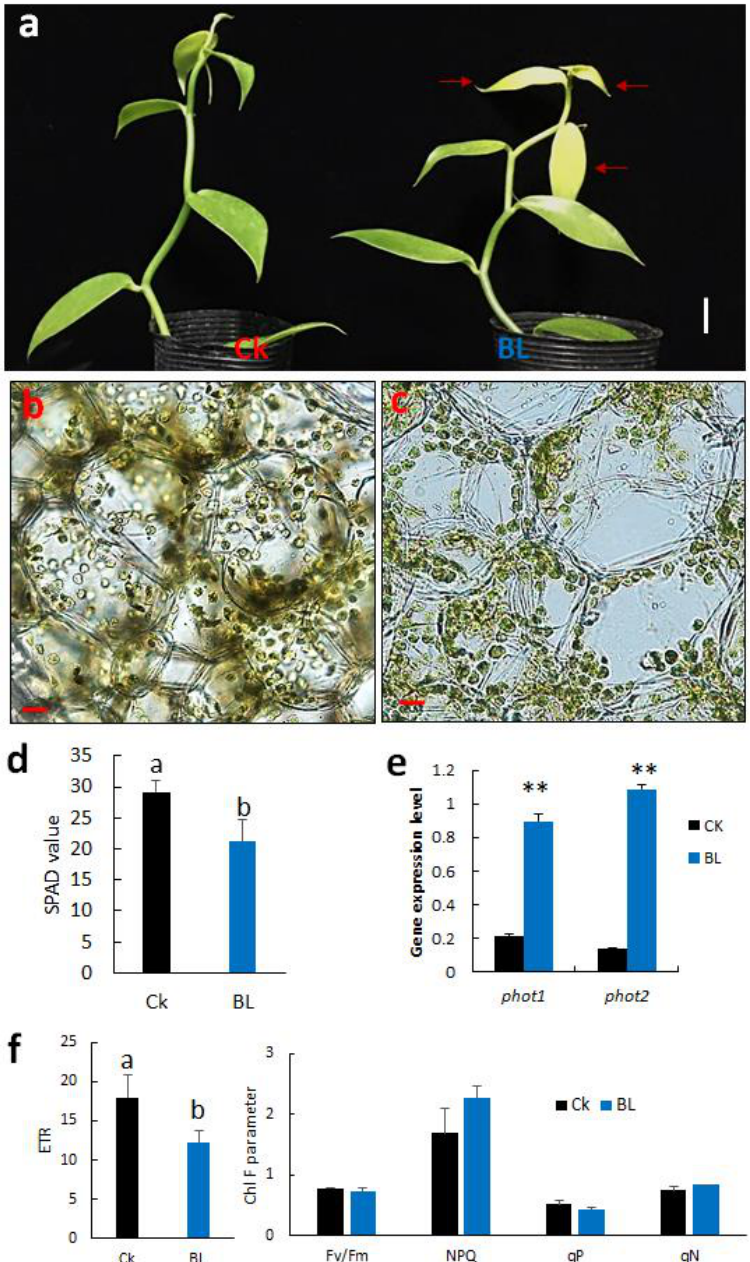
Figure 3. Effect of BL-acclimation on vanilla orchid growth, chloroplast movement, gene expression, and Chl F capacity. ( a ) BL-acclimation for 12 days (BL) affected vanilla orchid growth. Ck, vanilla grown in a greenhouse without BL pretreatment. BL100 treatment for 12 days showed some signs of photobleaching (right panel). Red arrows indicate the L3 has photoinhibition phenotype. Bars, 2 cm. Cross-section of the third newly established leaf (L3) showed that chloroplasts were distributed randomly in Ck ( b ), but chloroplasts moved to the anticlinal (side) walls after BL-acclimation ( c ). Bars, 20 μ m ( b , c ). ( d ) BL-acclimation reduced SPAD reading due to chloroplast avoidance. ( e ) BL-acclimation upregulated the gene expression levels of blue-light photoreceptors, phot1 and phot2 . ( f ) BL-acclimation altered Chl F capacity. ETR, electron transport rate; Fv/Fm, nonphotochemical quenching (NPQ); qP, photochemical quenching of fluorescence; qN, nonphotochemical quenching of fluorescence. Different letters indicate significant differences among treatments at p < 0.05, according to Duncan’s multiple range test (DMRT). Bar, SD of three biological replicates.